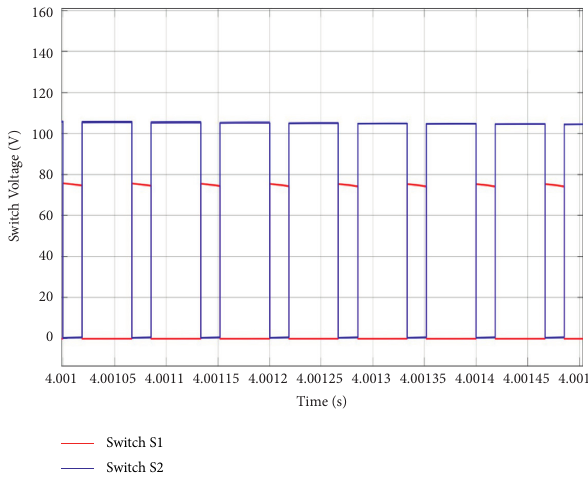
Figure 16: Voltage stress on switches S 1 and S 2 during boost mode operation of the converter.